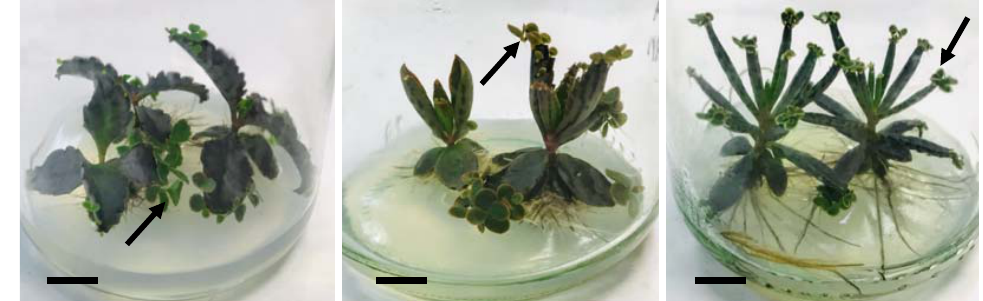
Figure 1. In vitro-cultured Bryophyllum plants. From left to right: B. daigremontianum (BD), B. × houghtonii (BH), and B. tubiflorum (BT). Arrows point at plantlets formed at the leaf margins. Bars = 1 cm. Figure adapted from [1].